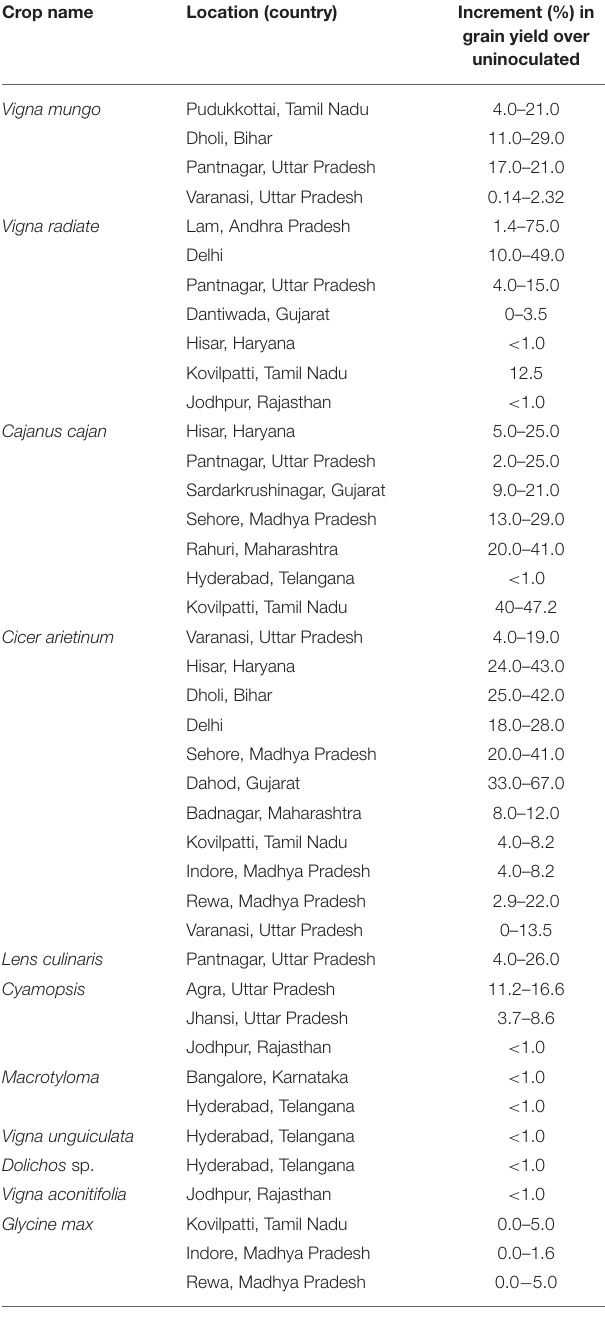
TABLE 3 | The increment (%) in the grain yield of legumes in response to rhizobial inoculation under different agroclimatic